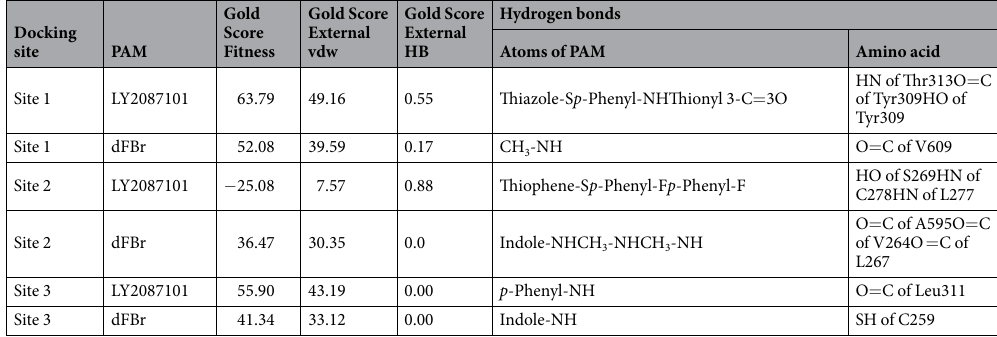
Table 3. GOLD analyses parameters of flexible docking of LY2087101and dFBr into potential binding site 1–3 in the ( α 4)3( β 2)2